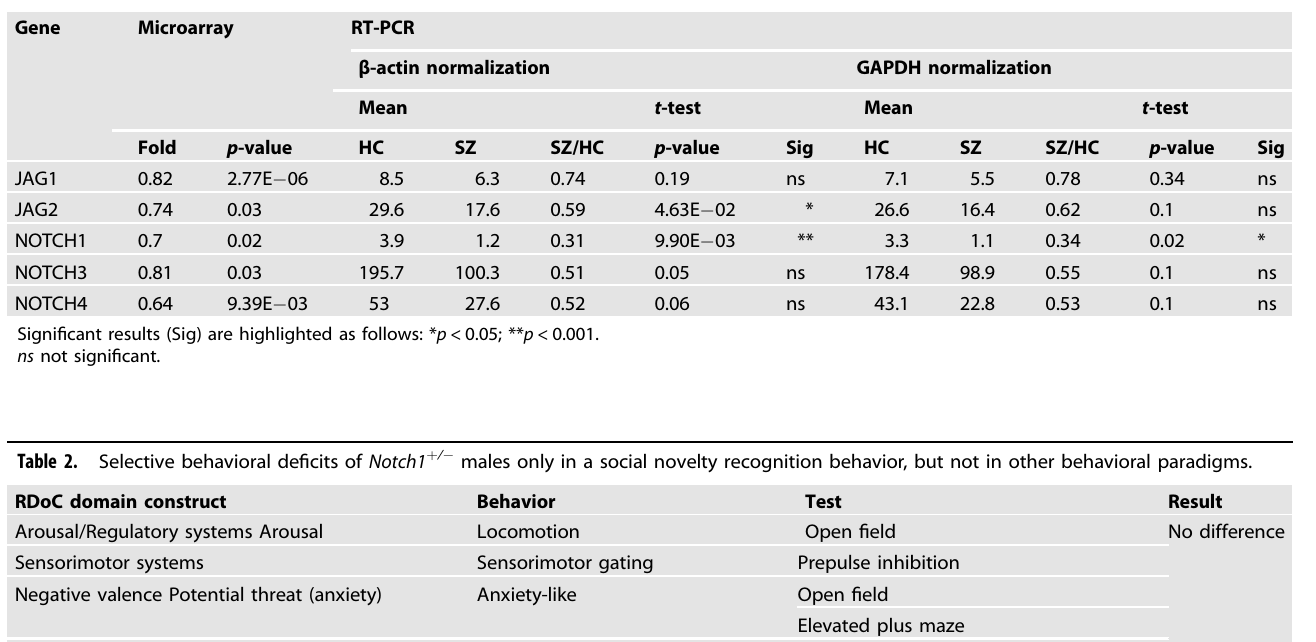
Signi fi cant results are highlighted in bold.